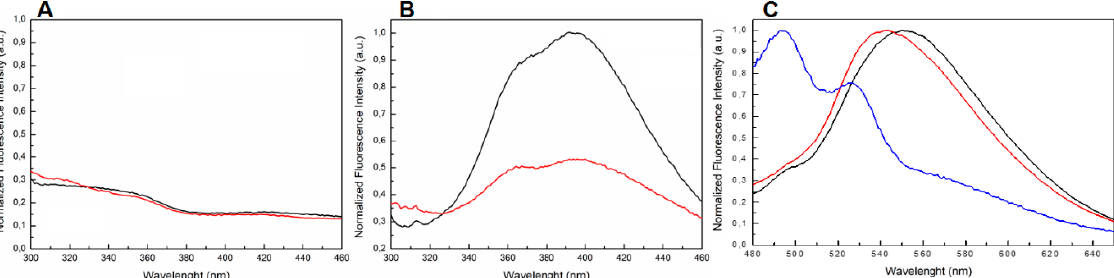
Figure 5. The normalized fluorescence spectra of ( A ) TBA (black line) and 5’-DMAzo-TBA (red line) in 100 K buffer excited at 255 nm and acquired in the range 300–460 nm. ( B ) T30695 (black line) and 5’-DMAzo-T30695 (red line) in 10 K buffer excited at 255 nm and acquired in the range 300–460 nm. ( C ) 5’-DMAzo-TBA (100 K buffer, red line), 5’-DMAzo-T30695 (10K buffer, black line) and free DMAzo (10 K buffer, blue line) excited at 450 nm and acquired in the range 480–650 nm.